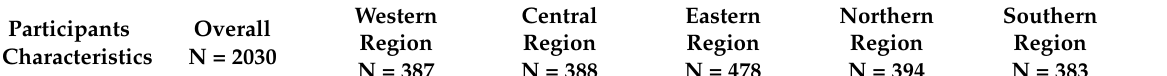
Table 2. Survey questions to assess contextual influences of vaccine